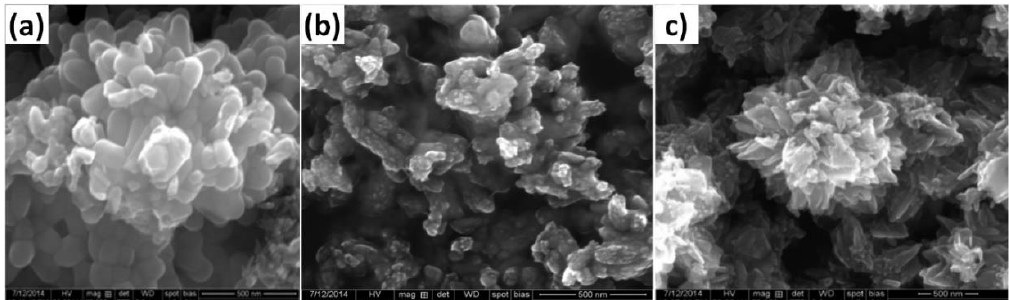
Figure 78. Schematic of the experimental procedure. Products synthesised by the microwave assisted annealing process. Reprinted from [893], Copyright (2015), with permission from John Wiley & Sons Figure 79. SEM images of undoped ZnO and Ba doped ZnO nanoparticles. ( a ) ZnO, ( b ) Ba (1 at%) doped ZnO and ( c ) Ba (2 at%) doped ZnO. Products synthesised by the microwave assisted annealing process. Reprinted from [893], Copyright (2015), with permission from John Wiley & Sons Inc [the Wiley Companies, or their respective licensors]. All rights reserved. In order to re-use permission must be obtained from the rightsholder.